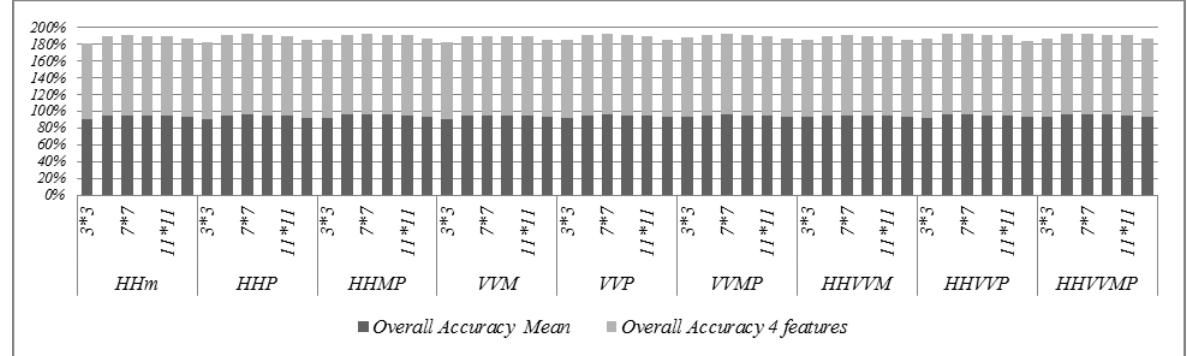
Figure 9. Overall accuracy of the SVM classification of Mean and combination of 4 features (Mean, Variance, Contrast and Dissimilarity) of the magnitude and power measurements 0f HH and VV